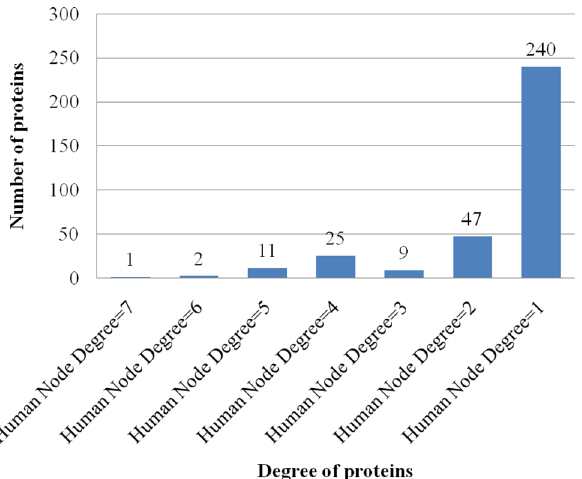
Fig 5. Average degree distribution of human protein nodes in dengue–human PPI network. It can be noted from the figure that at human node degree= 1, there is a maximum number(240) of interactions, and at humannode degree= 7, there is only 1 interaction. Therefore, most of the human proteins interact with 1 dengueprotein, and a majority of human proteinsparticipatein a few interactions. PPI, protein–protein